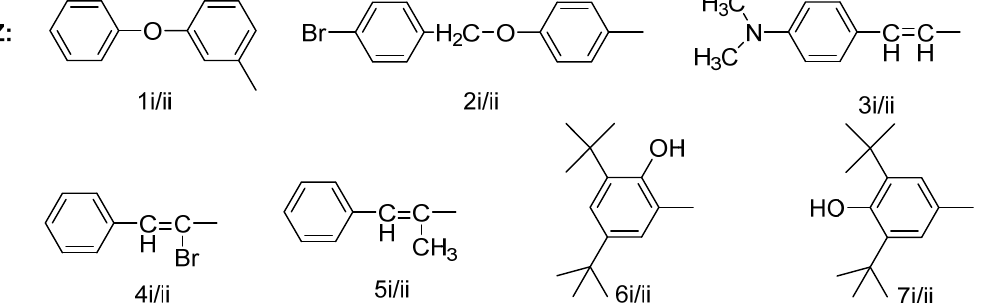
Figure 1. General structure of the novel synthesized derivatives.